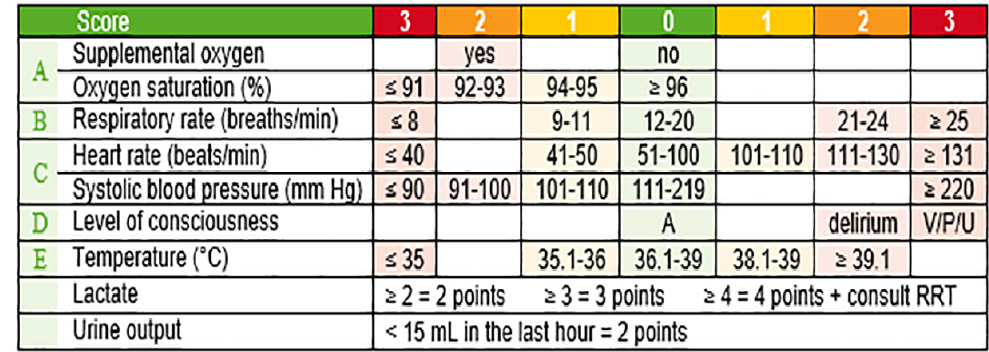
Figure 1. The seven standard variables plus two additional variables and point allocation for each variable. A , alert; V , response to voice; P , response to pain; U , unresponsive; RRT , rapid response team; mL ,